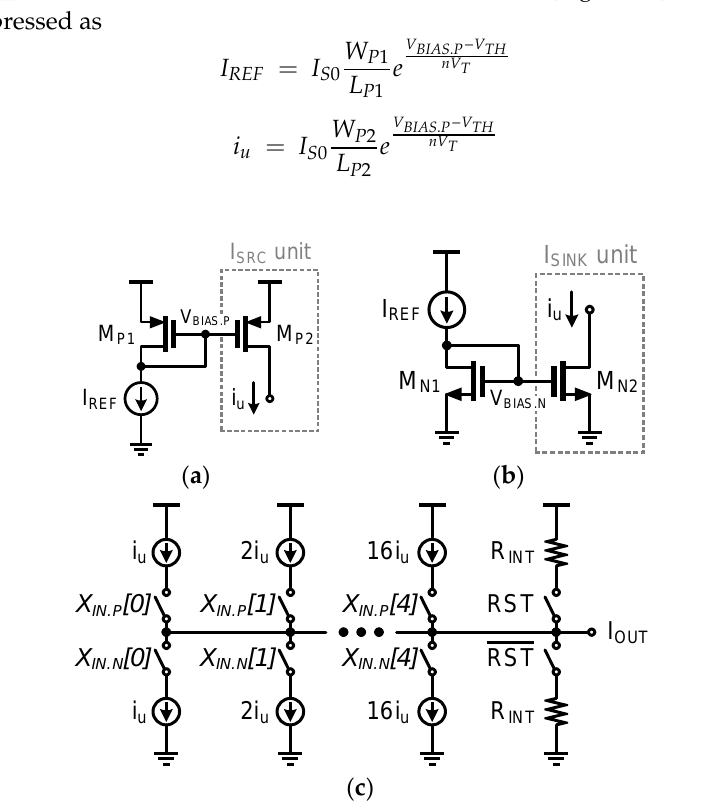
Figure 8. Input current DAC: ( a ) current source unit, ( b ) current sink unit, ( c ) half-circuit of the differential DAC.